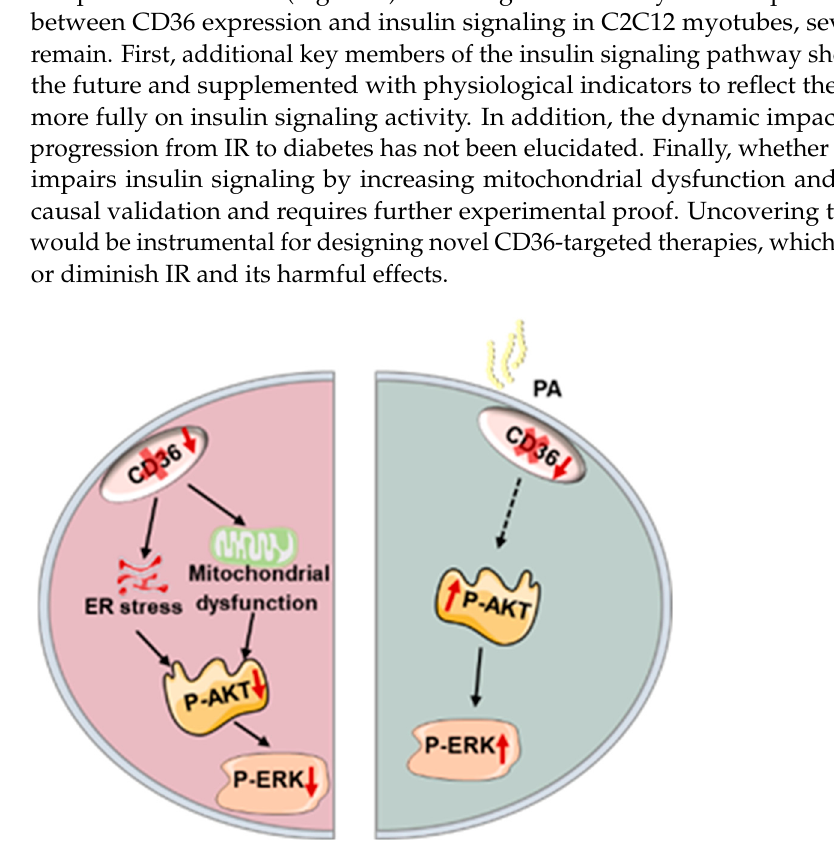
Figure 6. Schematic representation of the hypothesis that the differential role of CD36 in the regulation of muscle insulin response depends on palmitic acid load .